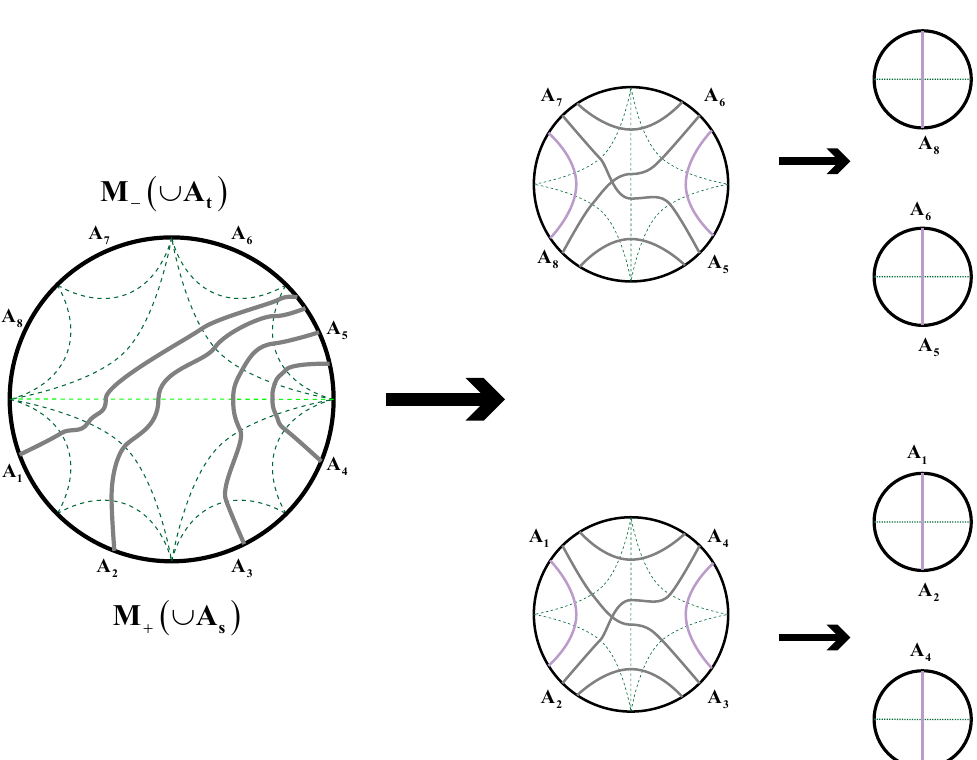
Figure 12 . Removing all entanglement between the set of A s and the set of A t (we only draw a few of relevant thread bundles, i.e., the thick grey lines in the figure), the original bulk spacetime N is split into two independent holographic bulk spacetimes N + and N − . With this process repeating, finally, a bulk spacetime N will eventually disintegrate into a tremendous number of small